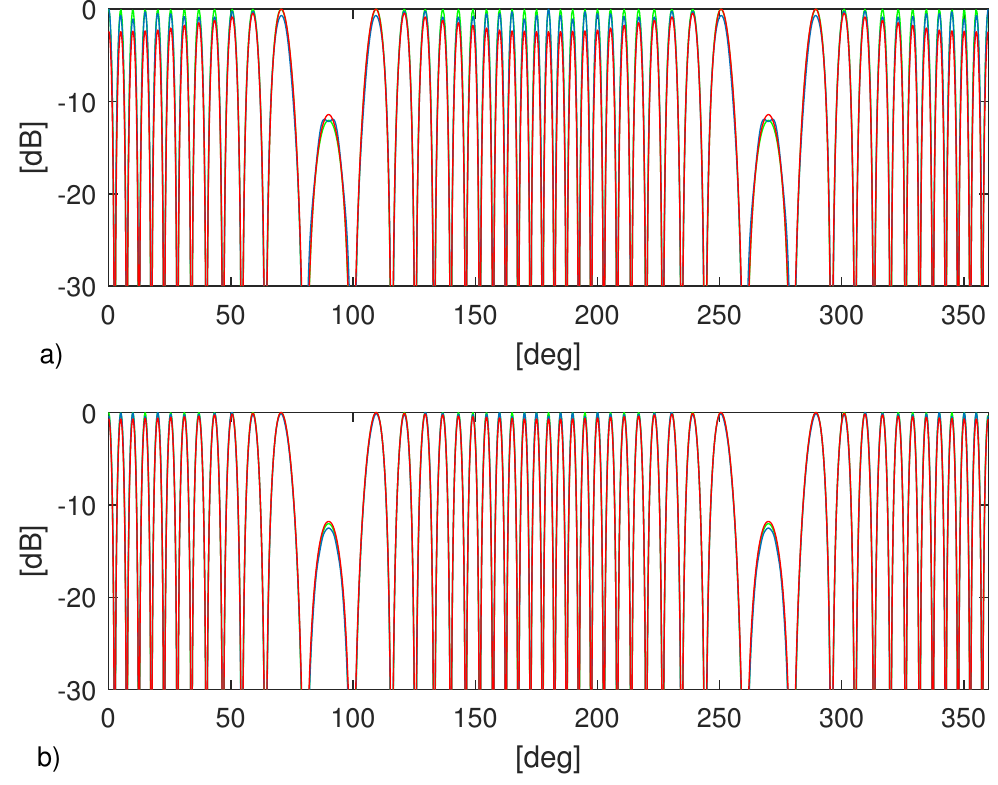
Figure 4. Normalized RCS (in db scale) at f = 1.75 GHz. The green lines refer to the actual RCS, while the blue and red lines to the ones computed from the multi-frequency and single-frequency images, respectively. ( a ) D I = [( − 1,1 ) × ( − 1,1 )] and ( b ) D I = [( − 2,2 ) × ( − 2,2 )]